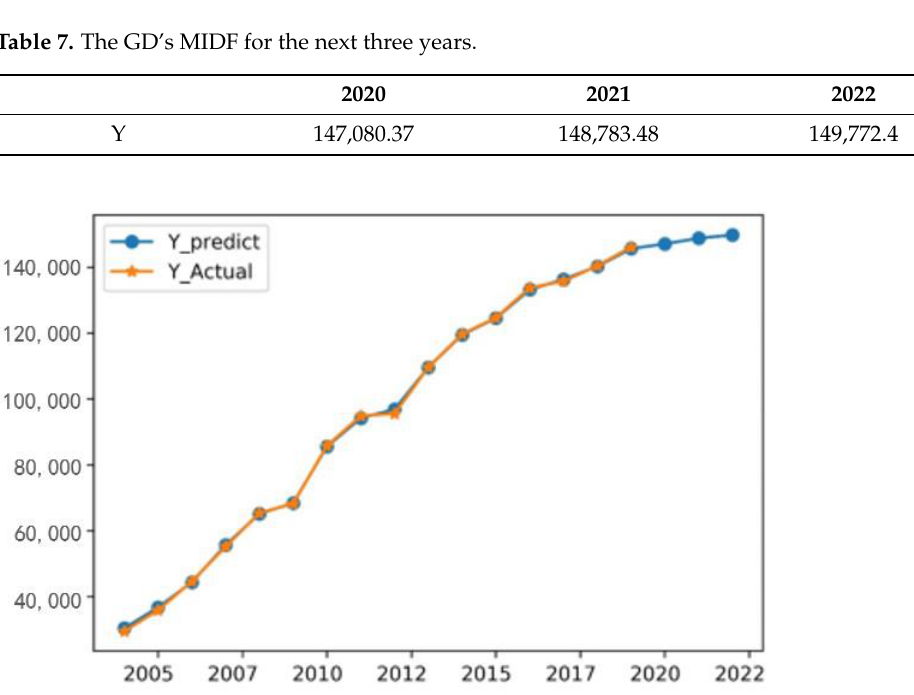
Table 6. Factor forecast for the next three years.